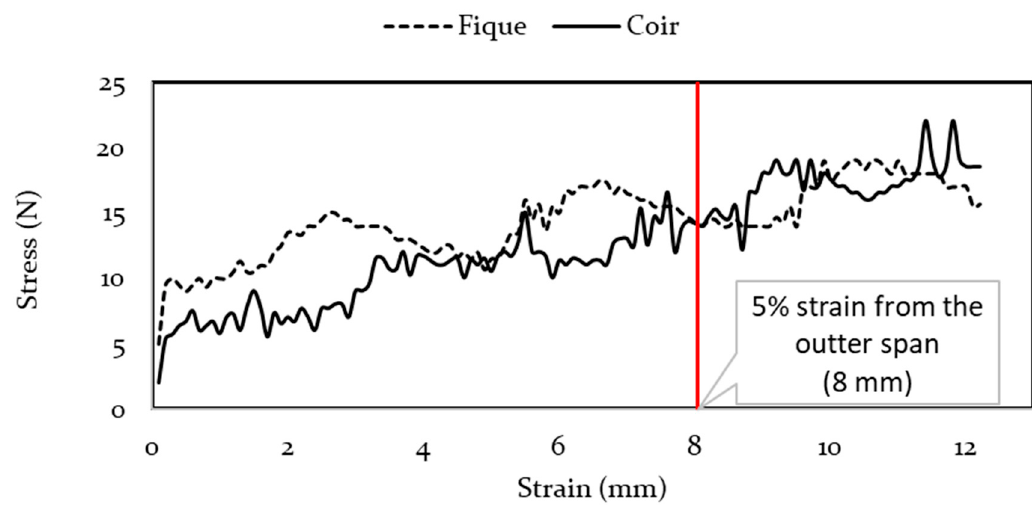
Figure 12. Panels stress-strain curve.